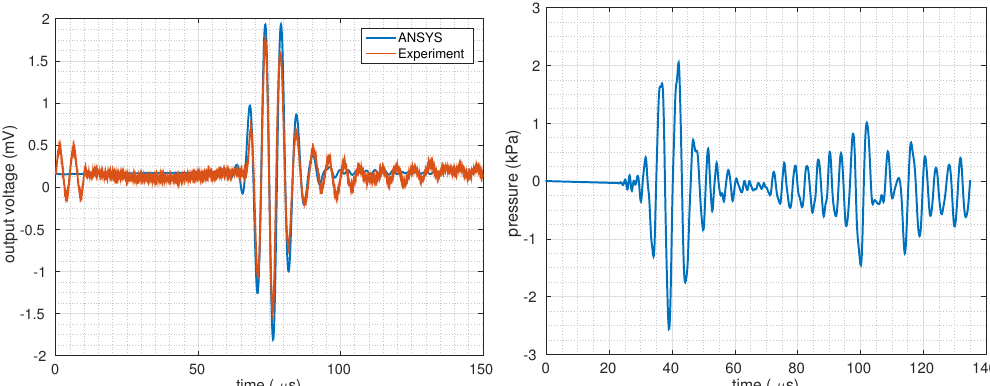
Figure 7. Comparison of experimental and analytical unamplified output signal ( left ), corresponding acoustic pressure ( right ).